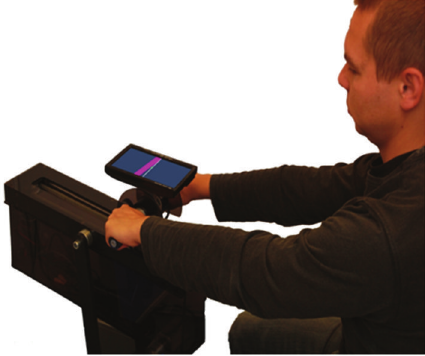
Figure 12: Bimanual handlebar. Reprinted with permission.